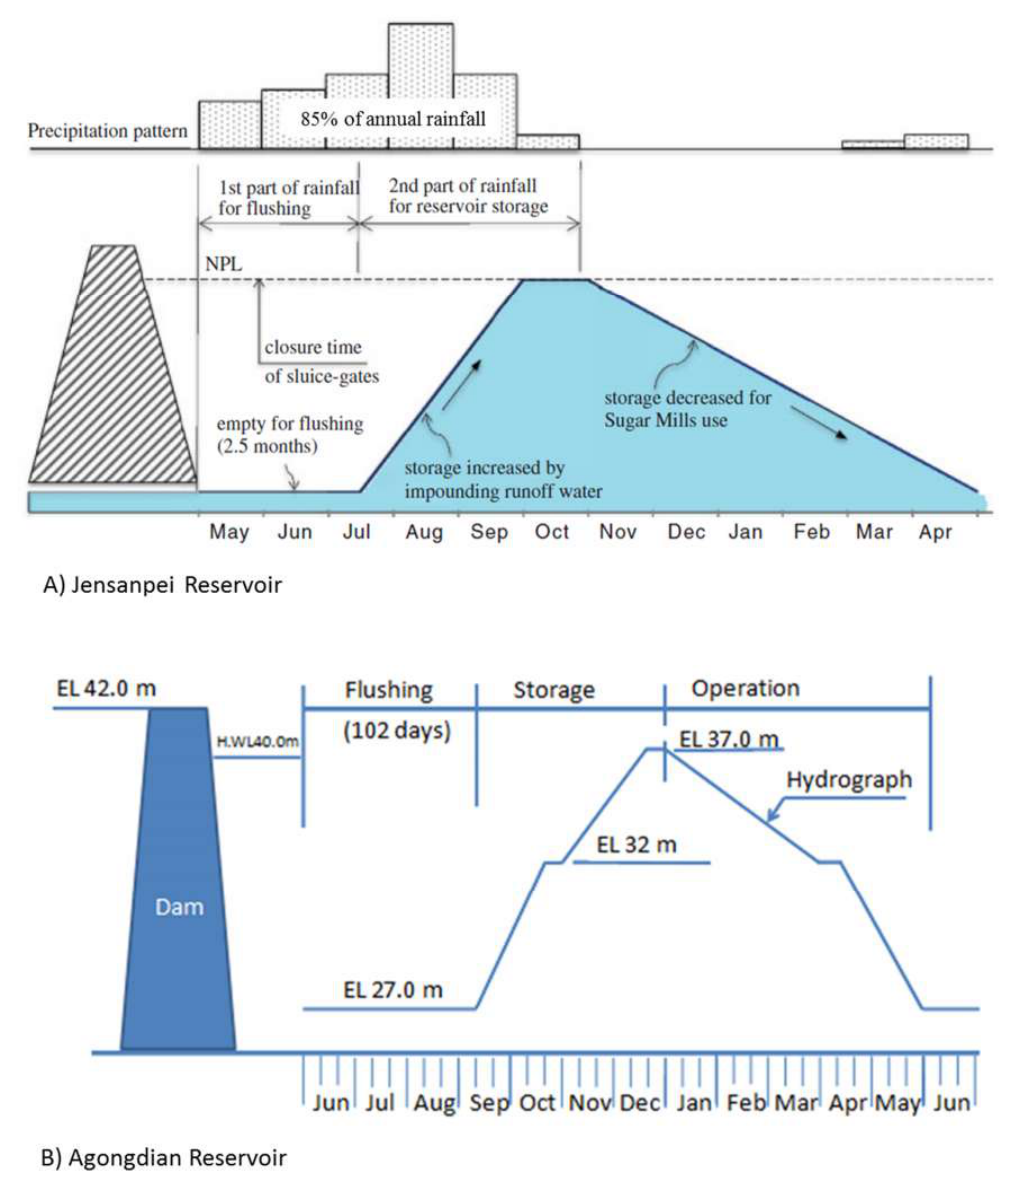
Figure 5. Operational pattern of ( A ) Jensanpei (Kondolf et al. [18]; updated from Hwang [22]) and ( B ) Agongdian reservoirs (Reproduced from Hwang